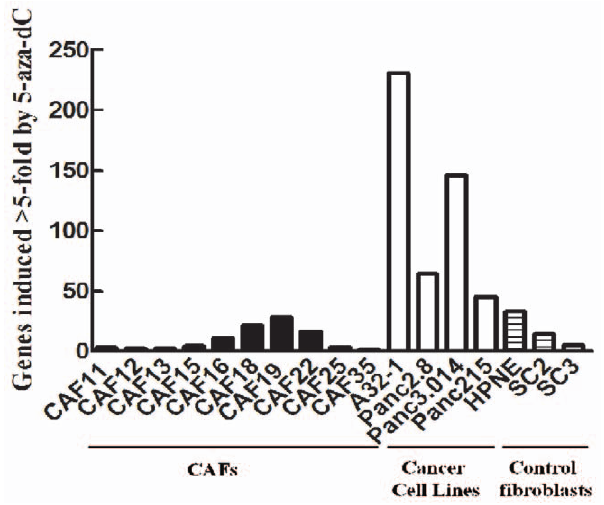
Figure 3. Number of genes induced by 5-aza-dC treatment in individual pancreatic CAFs, control fibroblasts and cell lines. An average of 123 6 86 genes were induced 5-fold or more by 5-aza-dC treatment in four pancreatic cancer cell lines, 9 6 10 genes in ten pancreatic CAFs ( P =0.0009) and 17 6 14 genes in three control pancreatic fibroblast lines.